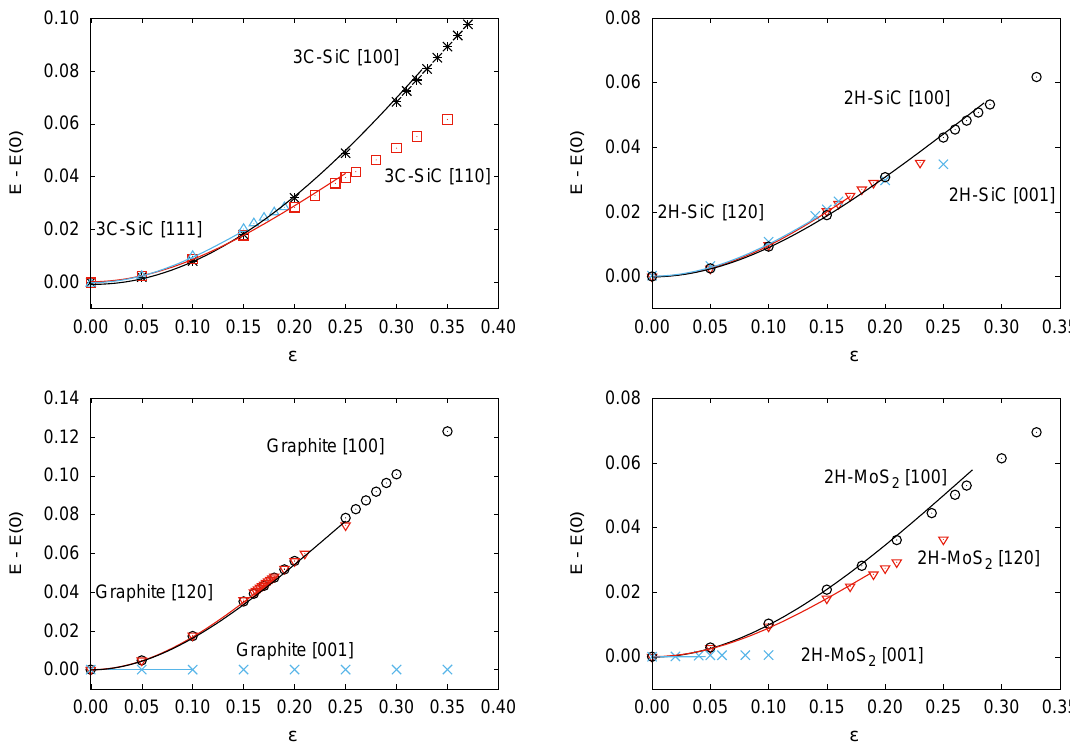
Figure 3. Calculated energy–strain curves for: 3C-SiC ( top left ), 2H-SiC ( top right ), Graphite ( bottom left ), and 2H-MoS 2 ( bottom right